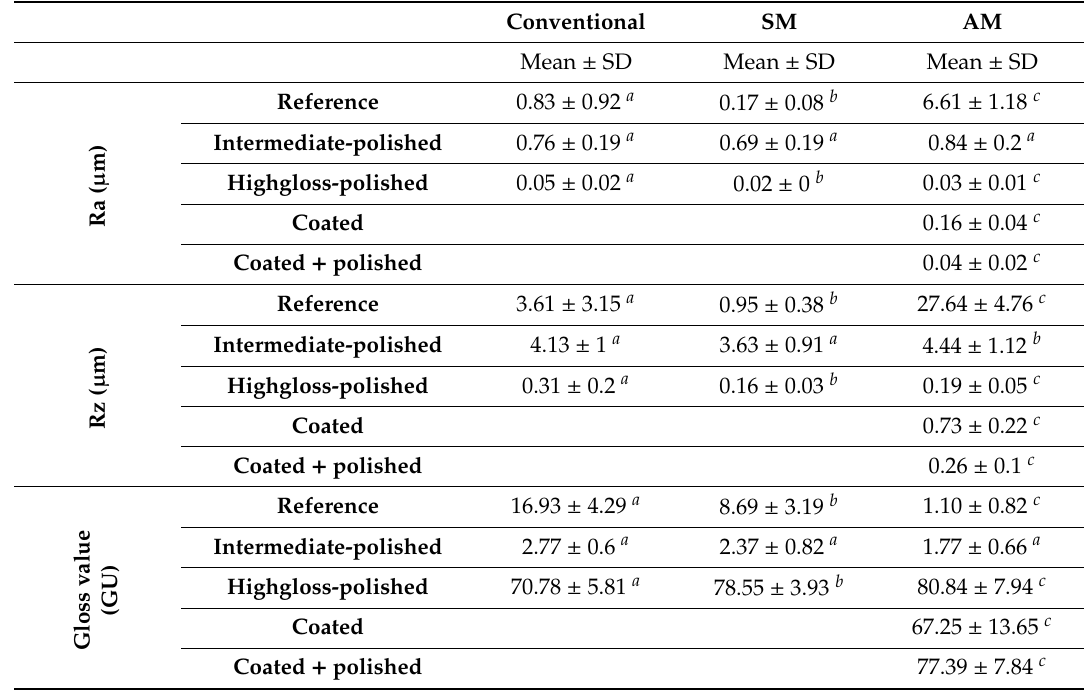
Figure 4. Surface roughness (R z ) of auto-polymerizing (conventional), milled (SM), and 3D printed (AM) denture base materials. The green horizontal lines represent the confidential intervals for each dataset. Table 1. Mean and SD values for “reference”, “intermediate-polished”, “highgloss-polished”, “coated”, and “coated + polished” specimens in conventional, SM, and AM groups. The letters a , b , and c indicate the p -value according to the Tukey HSD test.